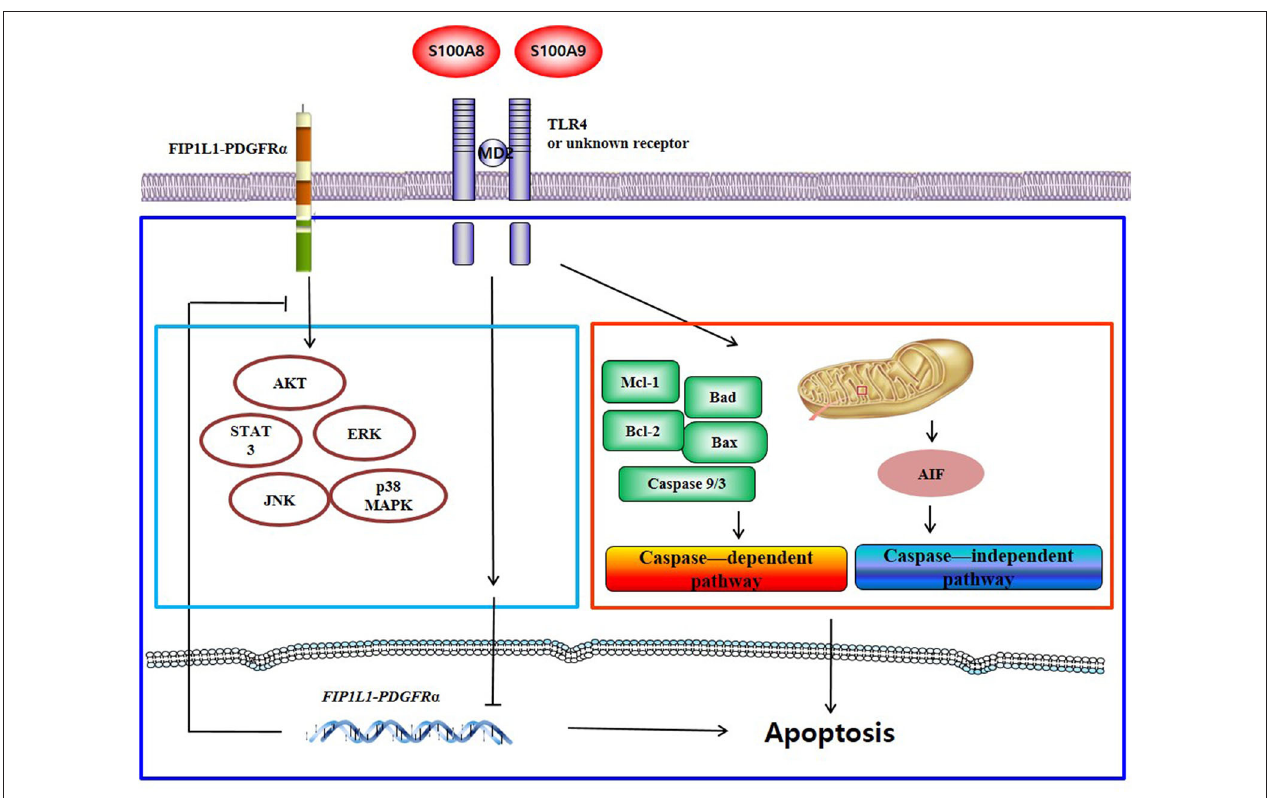
FIGURE 7 | Proposed apoptotic mechanism due to S100A8 and S100A9 in CEL eosinophils. S100A8 and S100A9 trigger apoptosis of chronic eosinophilic leukemia by suppressing FIP1L1-PDGFR α + -mediated proliferation by downregulating the mRNA and protein expression and by inducing mitochondrial-associated apoptosis via